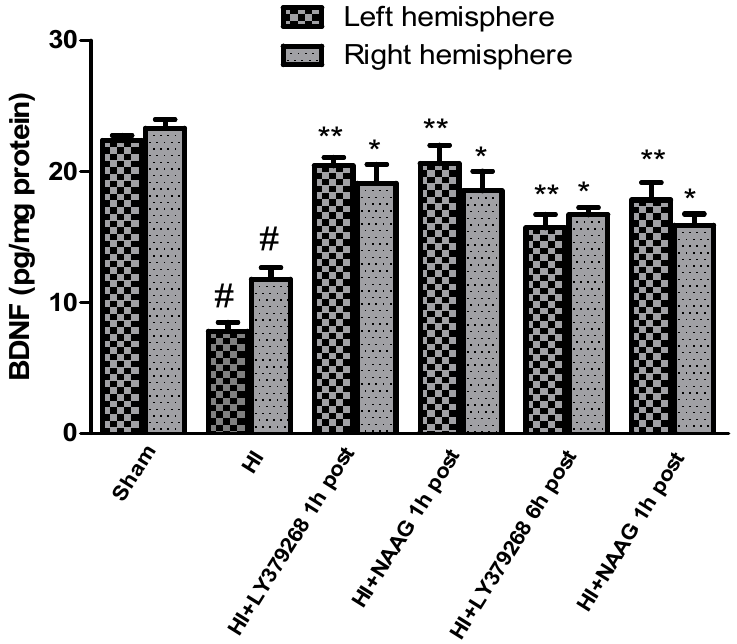
Figure 5. Effect of mGluR2 and mGluR3 agonists injection on BDNF changes after HI. Results are presented as mean ± SEM, n = 6–8; statistically significant differences: * p < 0.05, ** p < 0.001—different from H-I; # p < 0.001, different from sham operated group.